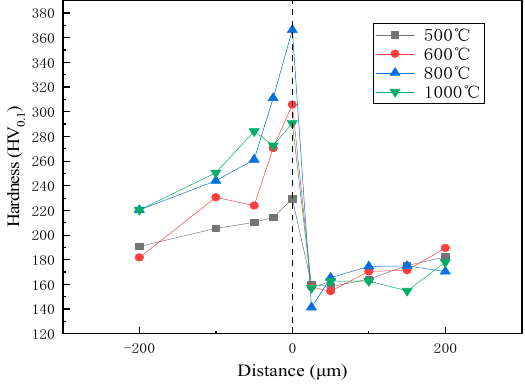
Figure 5. Hardness distribution near phase interface. Materials 2019 , 12 , x FOR PEER REVIEW